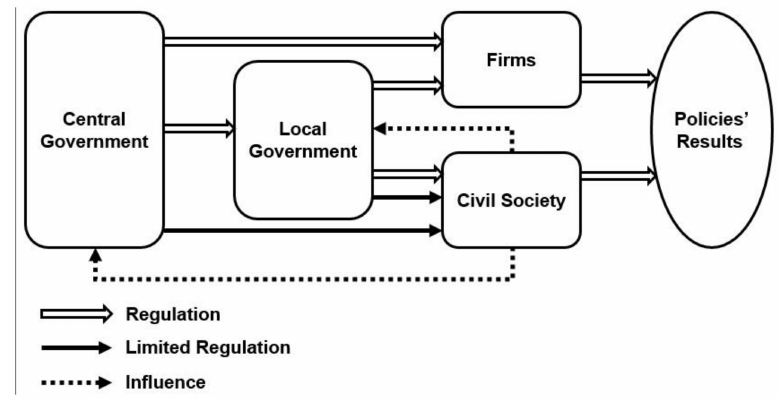
Figure 6. Chinese air pollution prevention and control policy network (Source: Drafted by